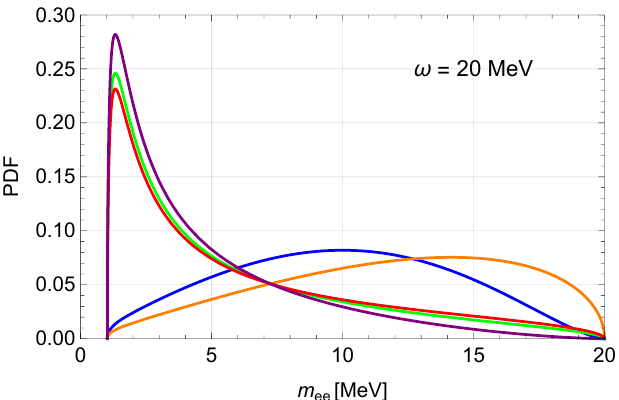
Figure 9 . Normalized invariant mass distributions of the e + e − pair from the various multipole contribution to the IPC process: L 0 (blue), L 1 (orange), E 1 (green), E 1 + L 1 (red), M 1